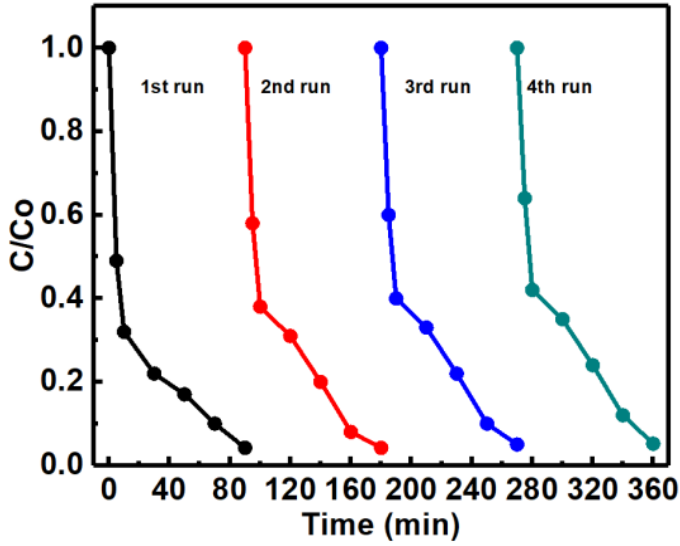
Figure 10. Cycling stability of ZnO/Fe 2 O 3 NFs for degradation of MB.